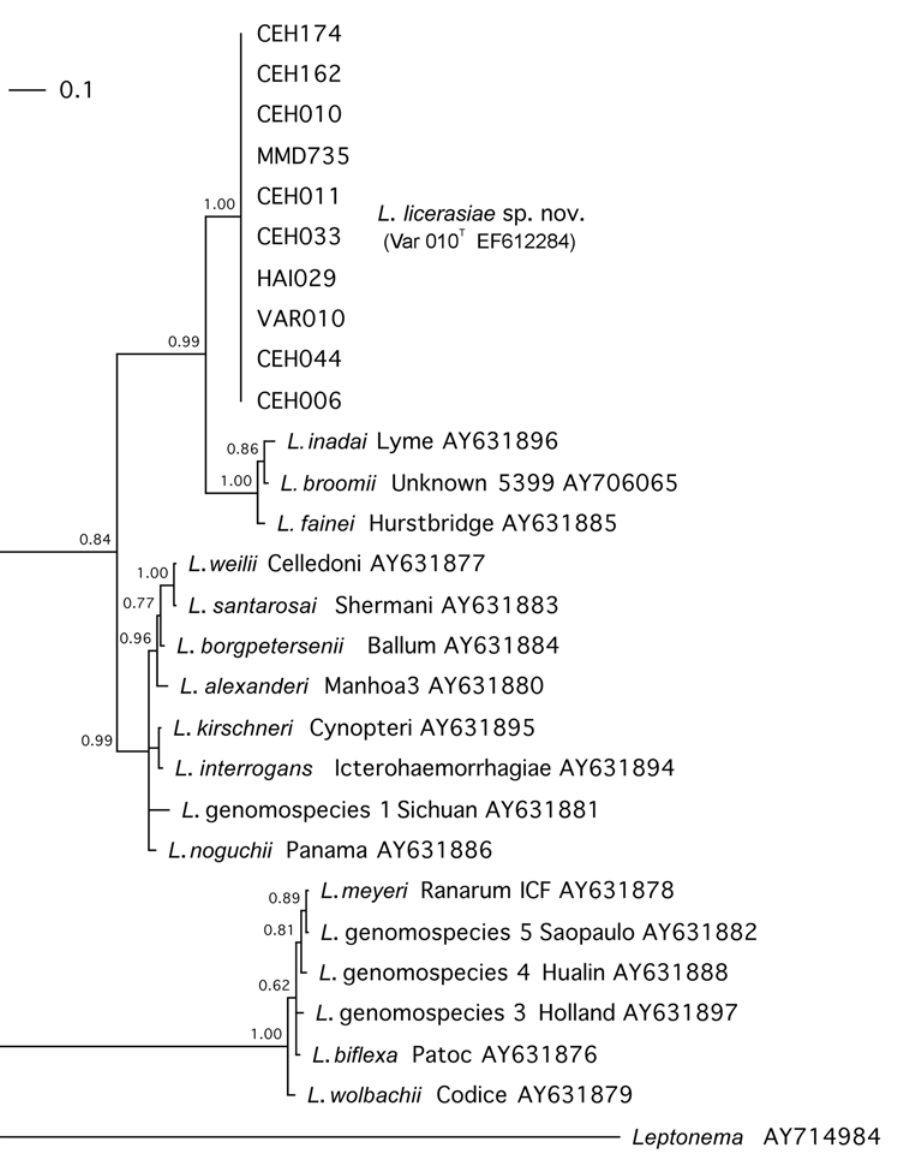
Figure 2. Phylogram of leptospiral 16S rRNA gene sequences generated by Bayesian phylogenetic analysis with simultaneous runs of 3,000,000 generations. Bootstrap confidence in assigning branch points is indicated at each node. For clarity, the intermediate clade of leptospires is placed on top, with the L. licerasiae strains first; the intermediates, pathogens and saprophytes groups of Leptospira are indicated at the right. Leptonema is used as the outgroup for comparison. The scale bar (upper left) shows the fractional difference in 16S rRNA gene nucleotide sequences. GenBank accession numbers are indicated to the right of each strain analyzed.